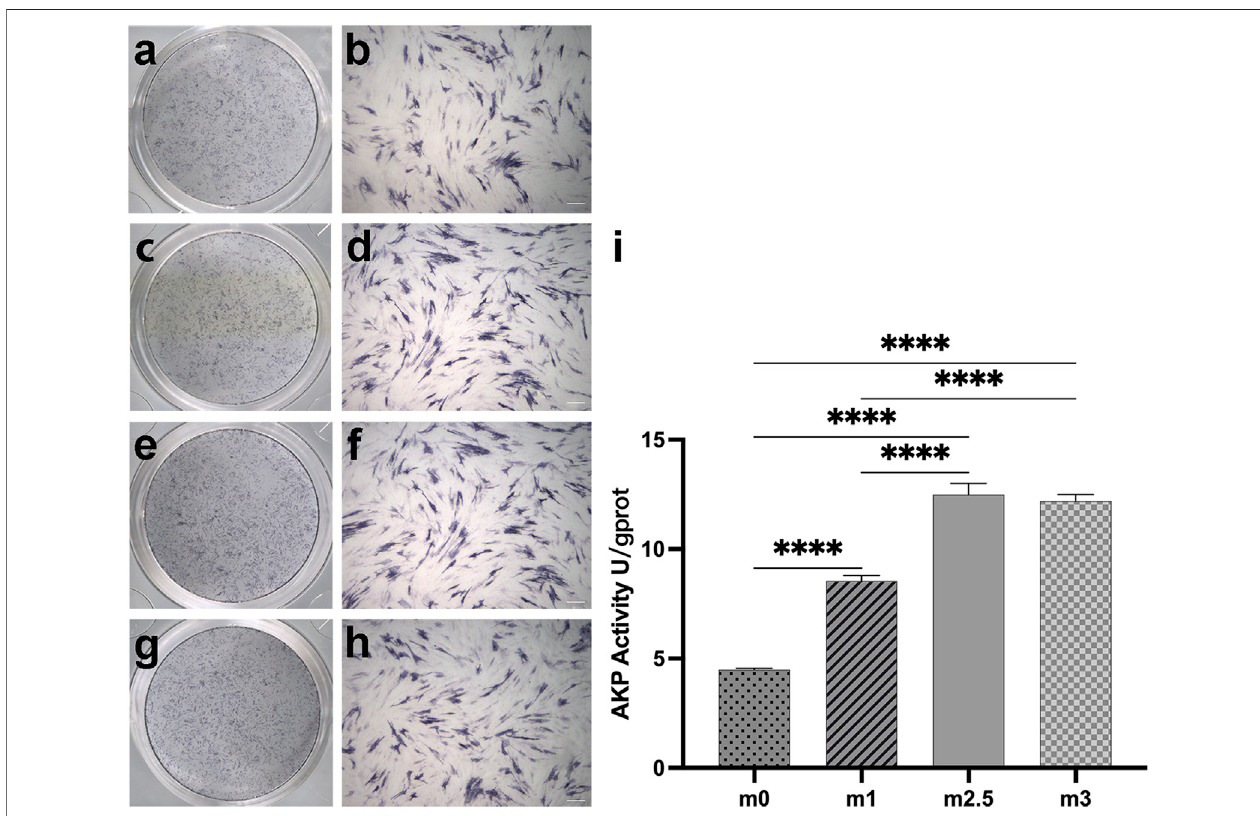
FIGURE 4 | (A – H) : alp staining pictures after 7 days of cell culture, M0 (A,B) , M1 (C,D) , M2.5 (E,F) , and M3 (G,H) under scanning and 10× microscope. (I) the different alp activities in quantitative. Scale bar for 200 µm.